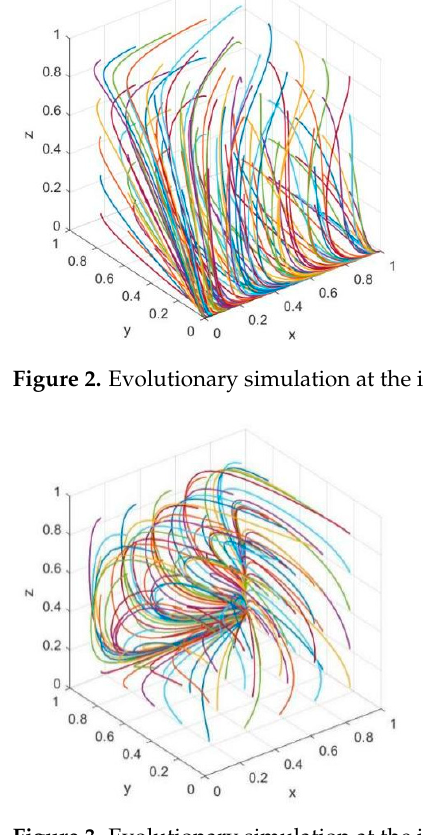
Figure 4. Evolutionary simulation at the initial stage point (1, 0, 1). Figure 5. Evolution simulation development at the initial stage point (1, 1, 1).